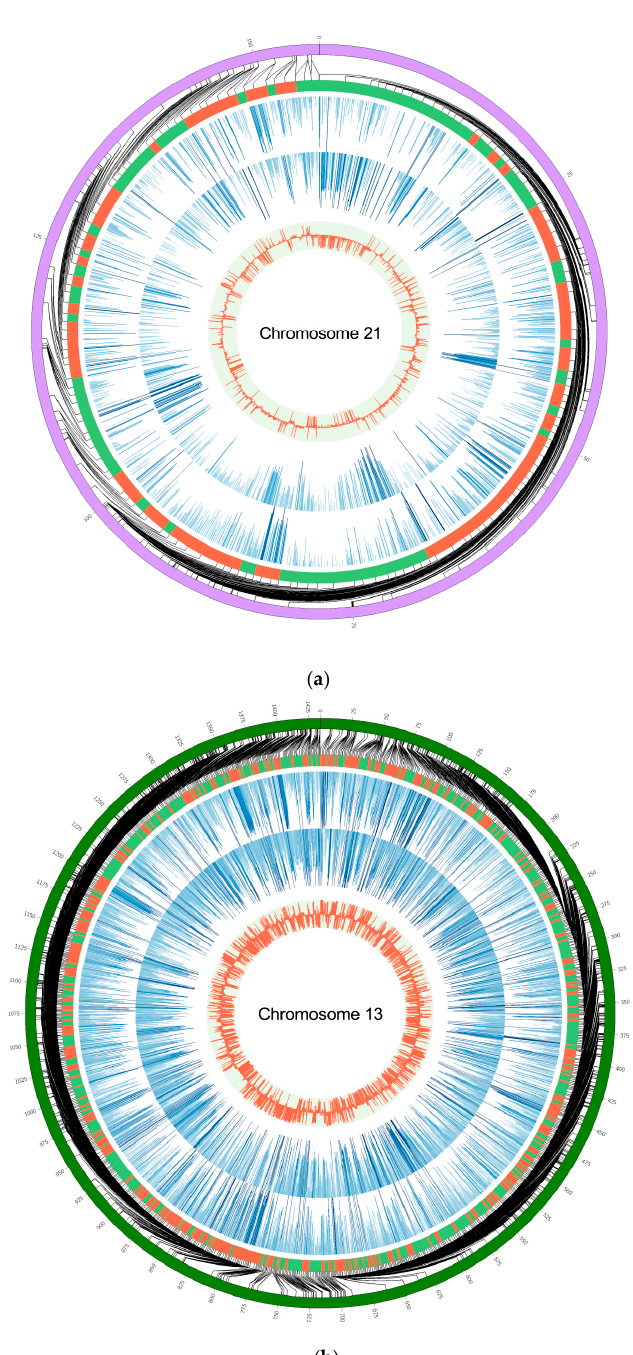
Figure 2. Analysis of di ff erentially methylated regions (DMRs). Two chromosomes with the least ( a ) and the most ( b ) amount of DMRs. The outer ring represents the position of the genomic chromosome; the second circle is the DMRs region: the red area represents the higher methylation level of HFD compared to the SND group and the green area represents the lower methylation level of HFD compared to the SND group; the third circle represents the methylation rate of each site of sample HFD; the fourth circle represents the methylation rate of each site of sample SND; the fifth circle represents the difference of methylation rate.